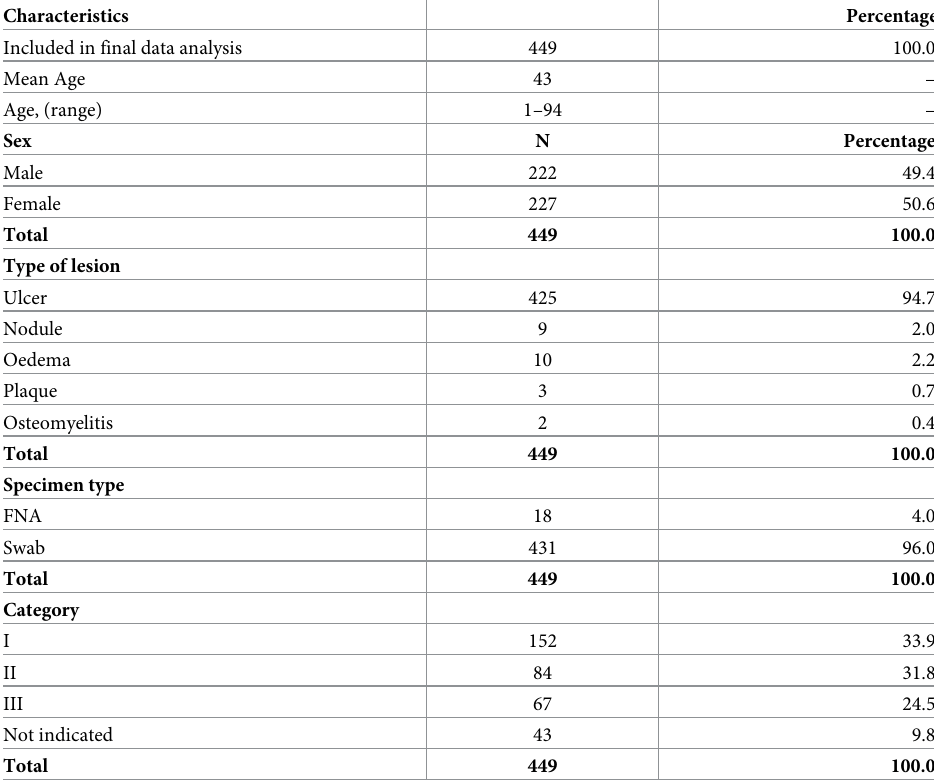
Table 1. Characteristics of all suspected cases of Buruli ulcer cases submitted for